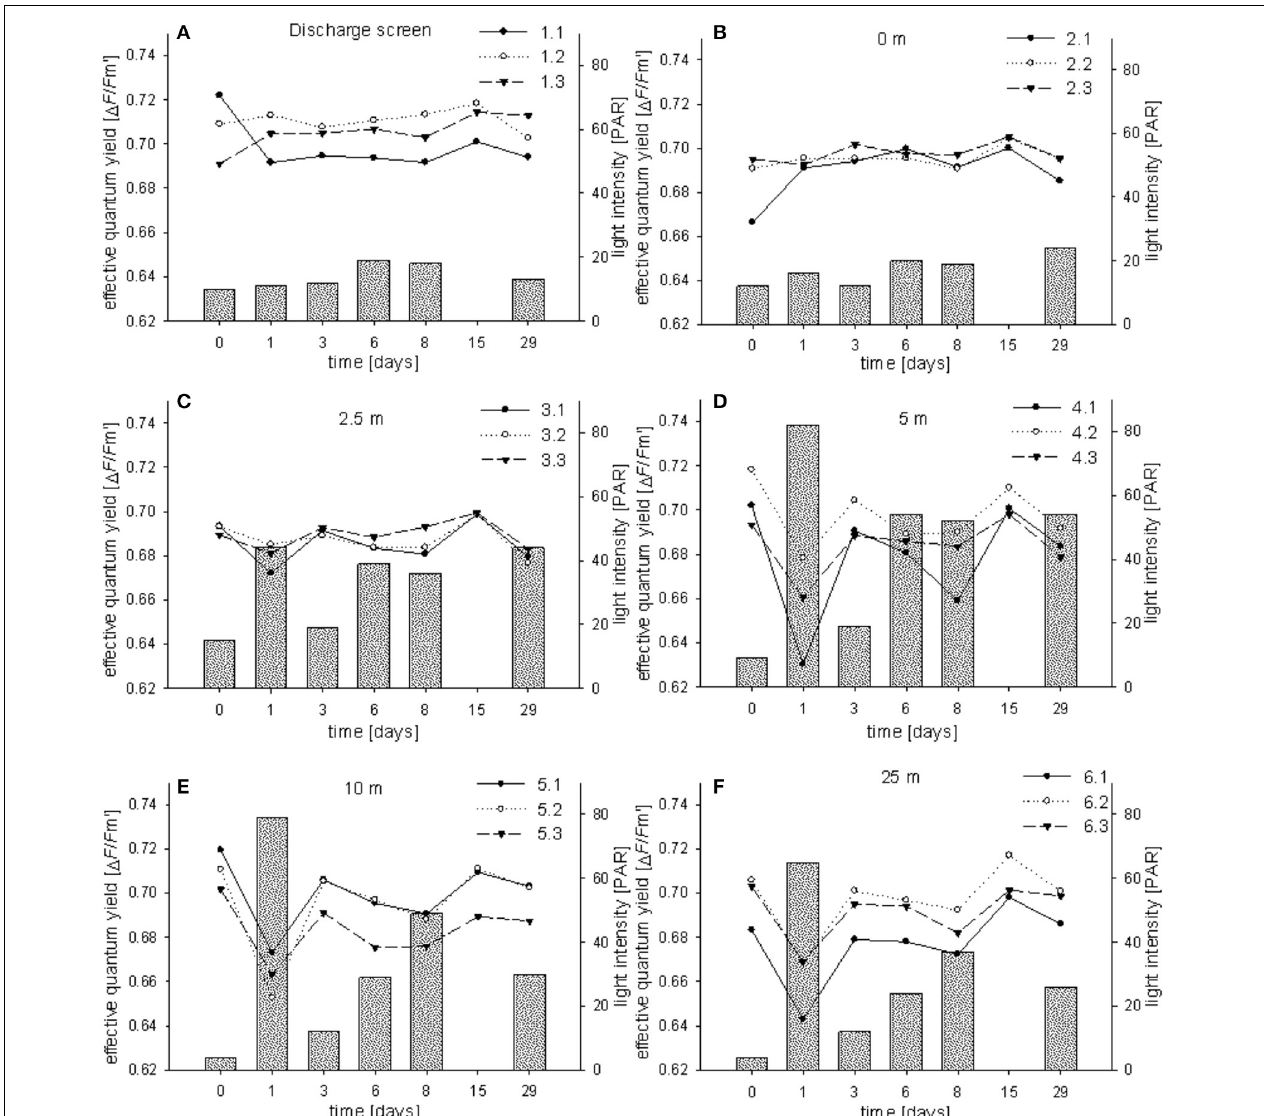
FIGURE 4 | Effective PSII quantum yields ( (cid:2) F / F m (cid:2) ) of individual Fungia granulosa specimens during the 29-day transplantation experiment at each station (A–F). Bars show photosynthetic active radiation